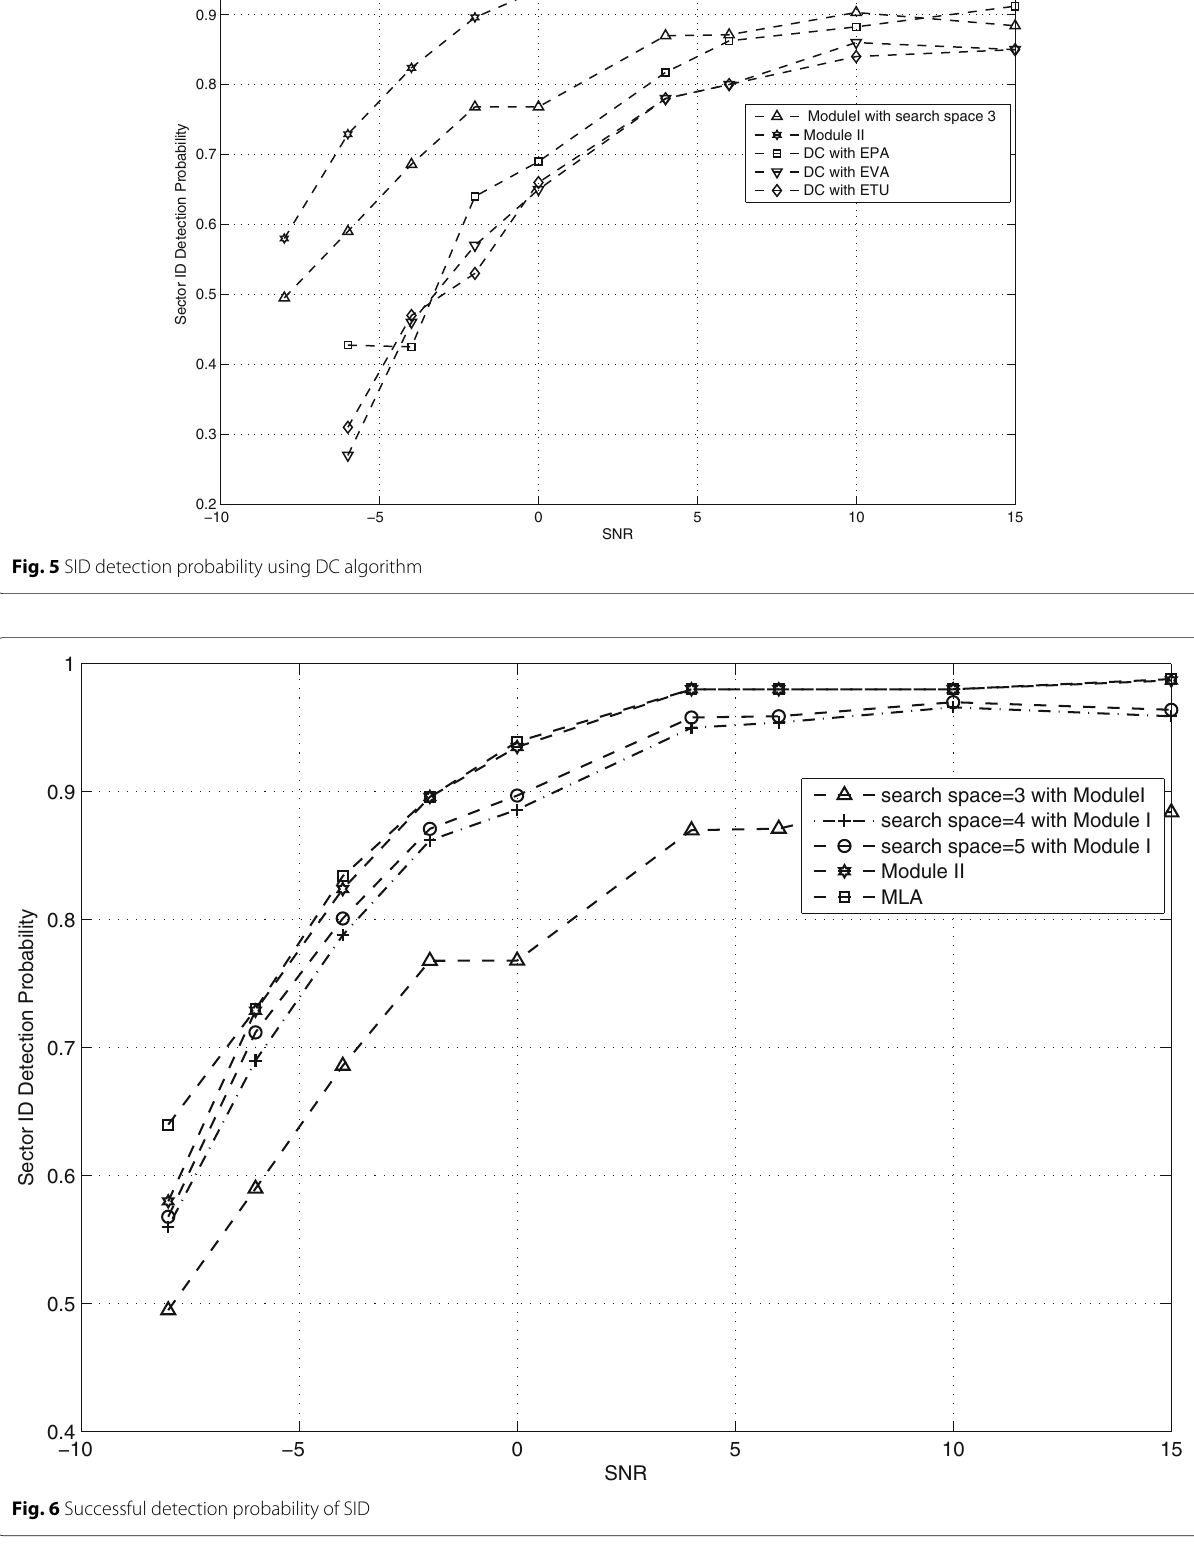
Fig. 6 Successful detection probability of